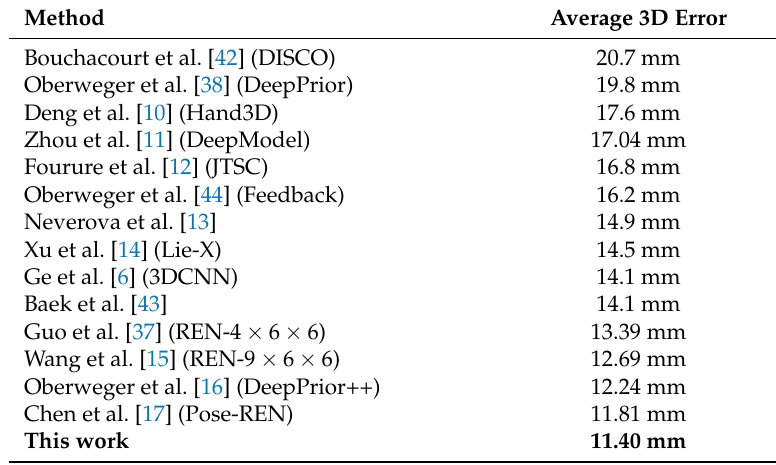
Table 1. On the NYU dataset [4], we compare the proposed approach to the state of the art. It proves that our method has better results by the evaluation metric of the average 3D joint error in the table